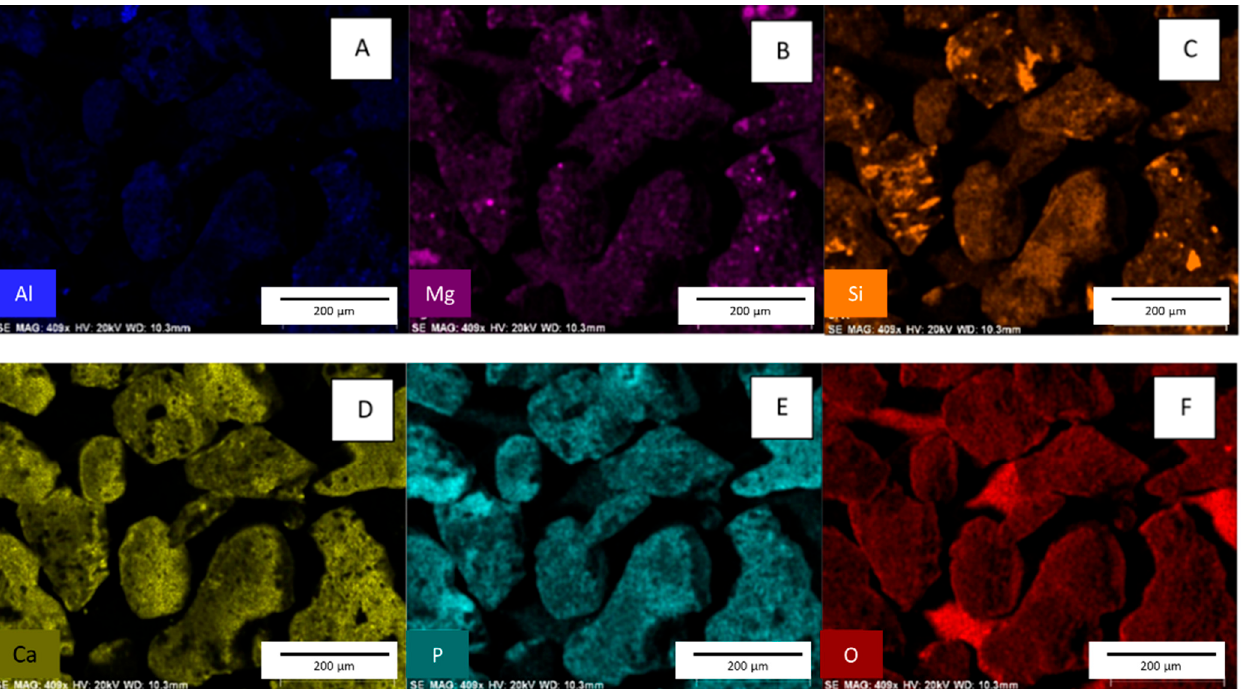
Figure 5. Images ( A – F ) are EDX surface scans of slag after the adsorption of phosphate. [pH = 5.0; adsorbent concentration = 0.002 g/mL; 500 mg/L PO 43 − solution; shaking time 24 h].